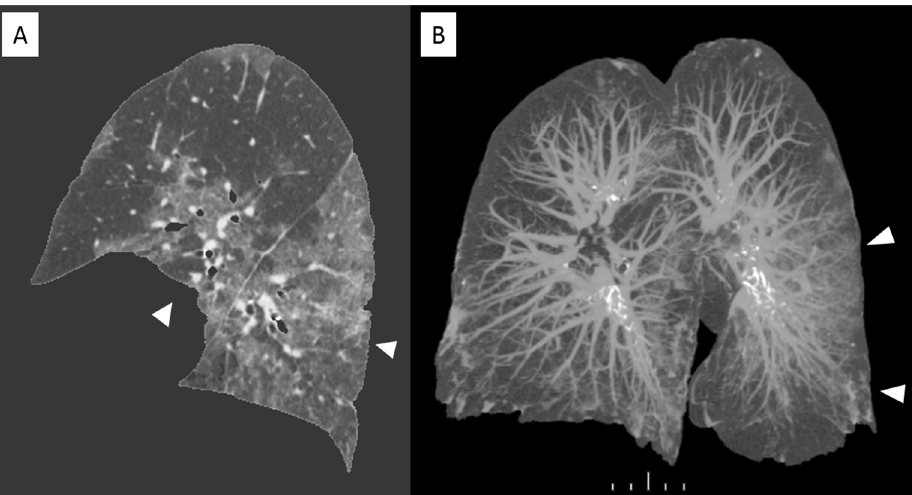
Figure 4. Sagittal view of a non-enhanced CT with software segmentation ( A ) showing extended GGOs (arrowheads). On the right the volume rendering recon of the same CT ( B ) highlighting the pulmonary vessels and the infected parenchyma hyperdense (arrowheads). in comparison with adjacent normal aerated lung.